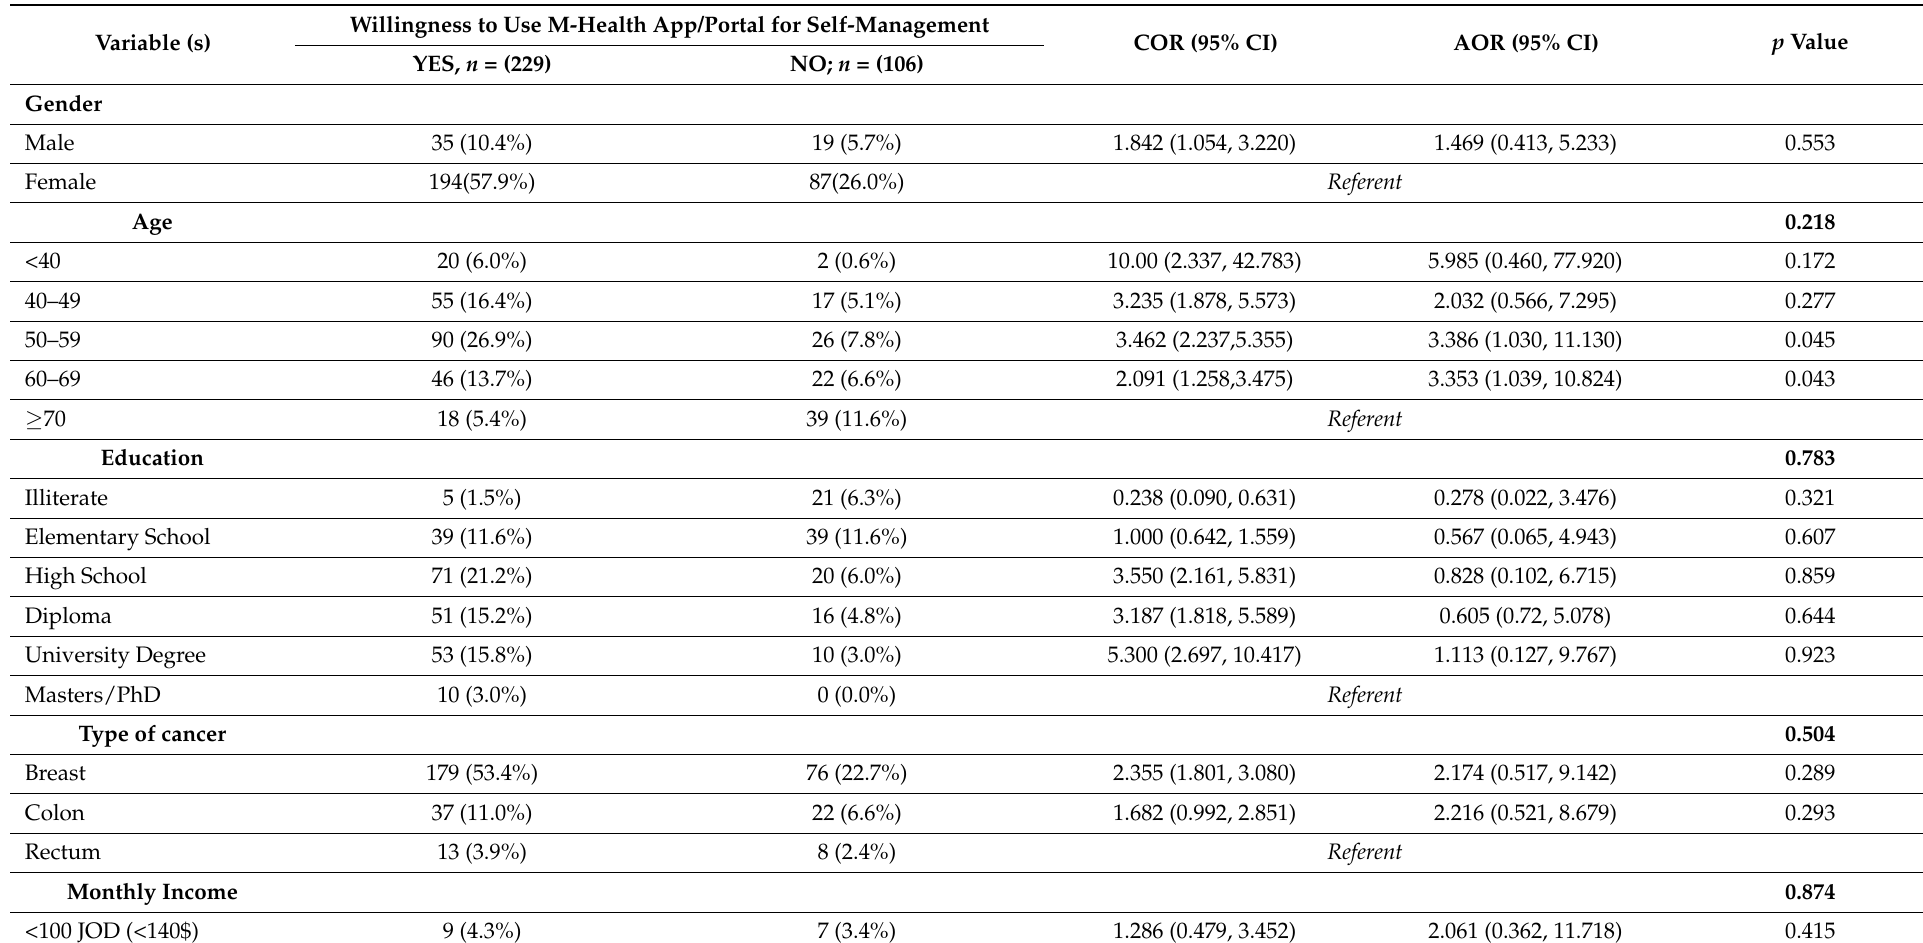
Table 7. Predictors of m-health app adoption for self-management in breast and colorectal cancer survivors, Jordan 2020, * p -value <0.05 indicates statistical